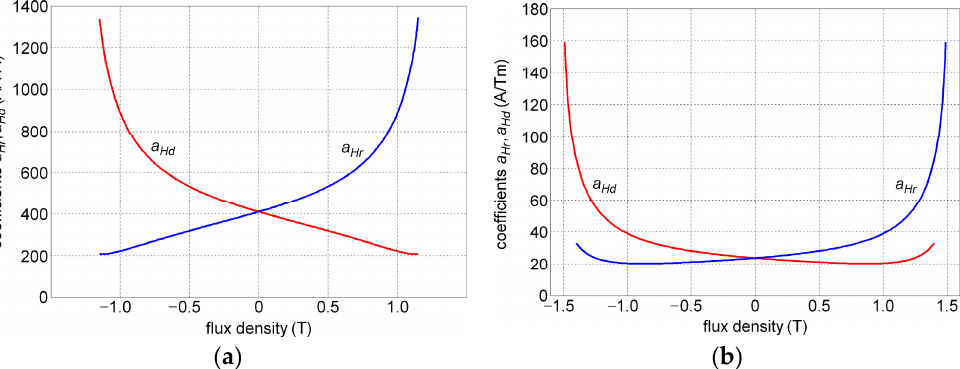
Energies 2021 , 14 , x FOR PEER REVIEW Figure 5. Dependencies of a Hr and a Hd on B for H 0 = 0 for ( a ) dynamo sheet M530-50A; ( b ) transformer sheet M120-27S.